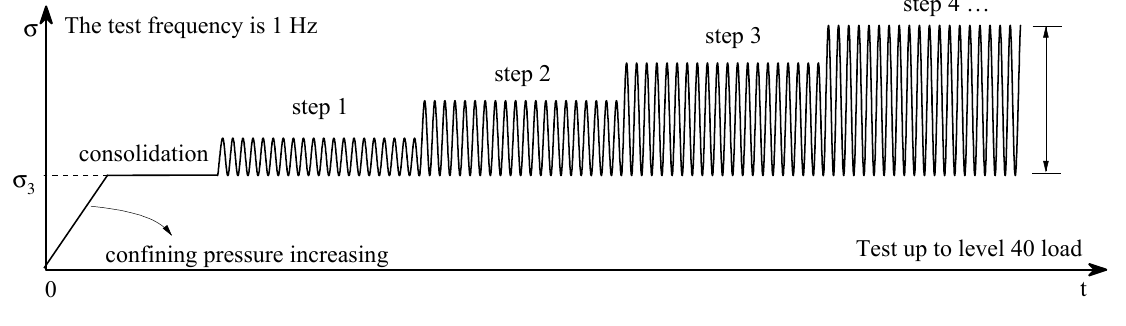
Figure 6. Test load.